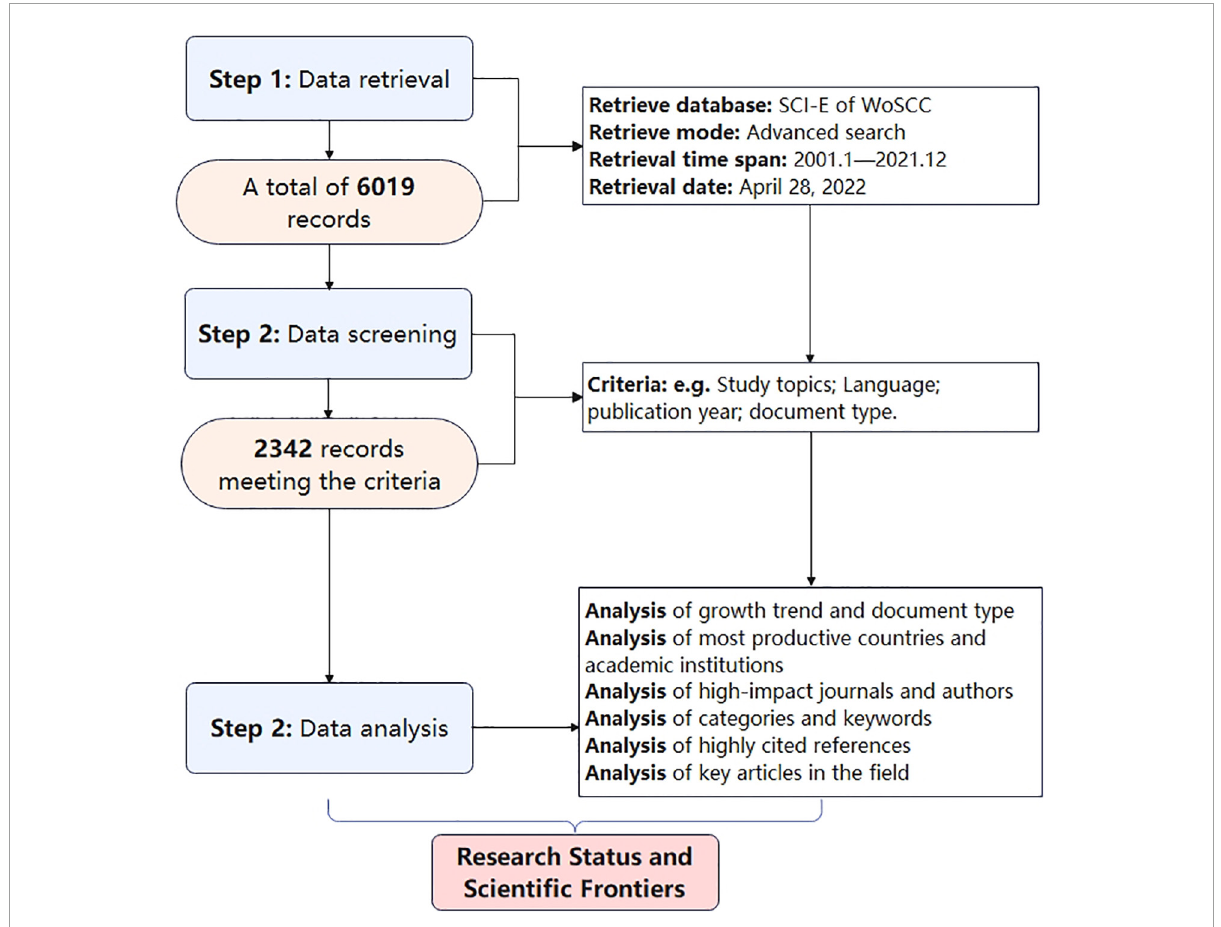
FIGURE1 Flowchart of document search, screening, and data